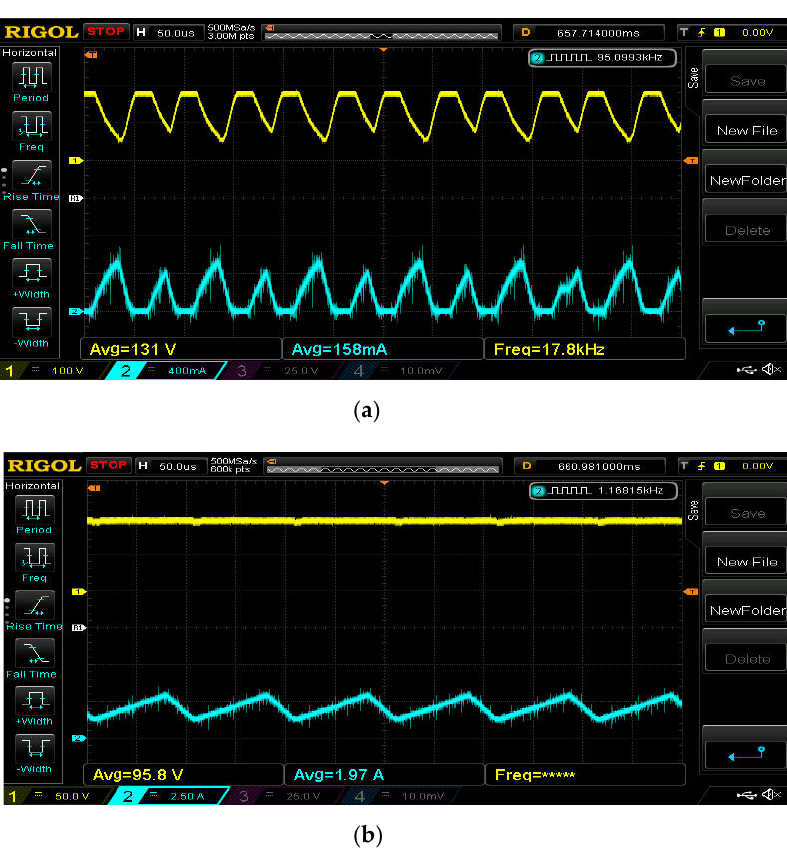
Figure 13. Experimental Wave Form of PV and Battery in ESS Discharging Domain.